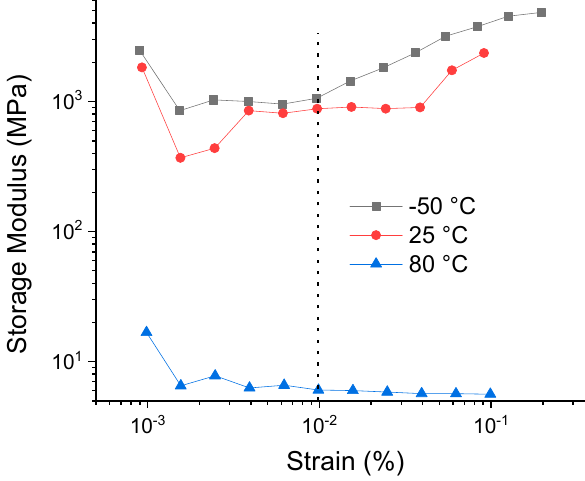
Figure 11. Strain sweep for PLA-60 at − 50, 25 and 80 °C.